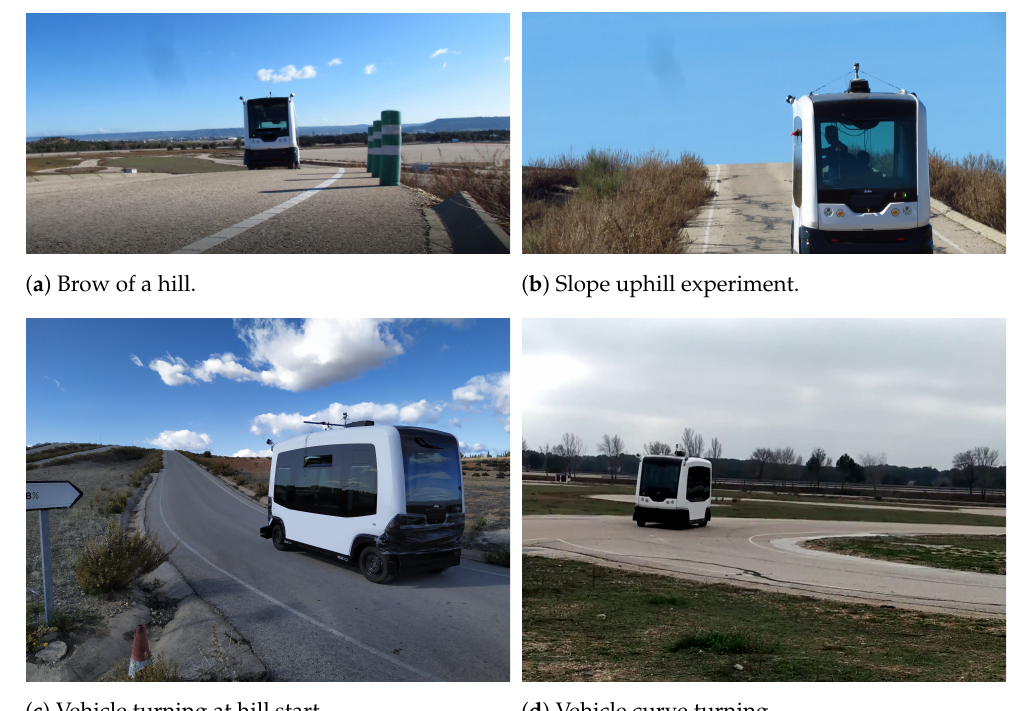
Figure 23. Vehicle experiments on the